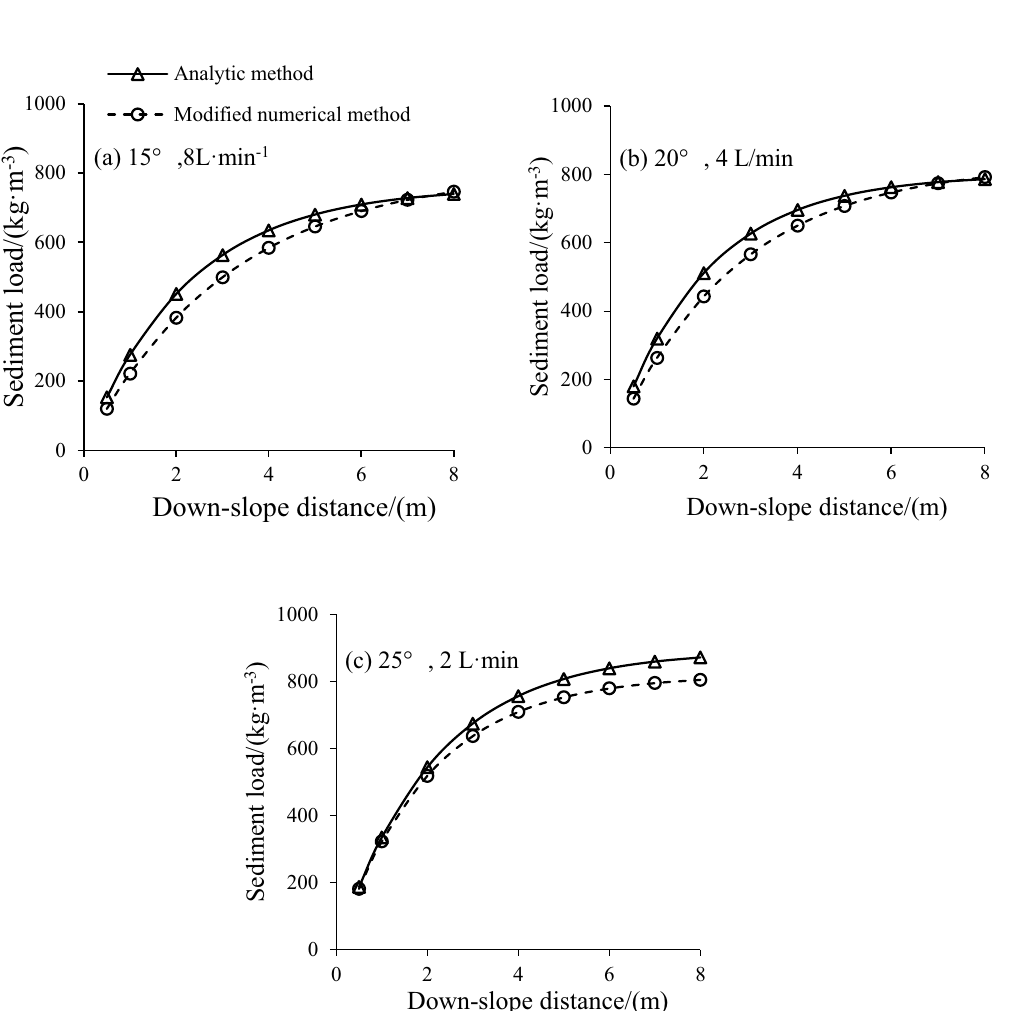
Figure 2. Comparisons of sediment distribution relationships by analytic method and the modified numerical